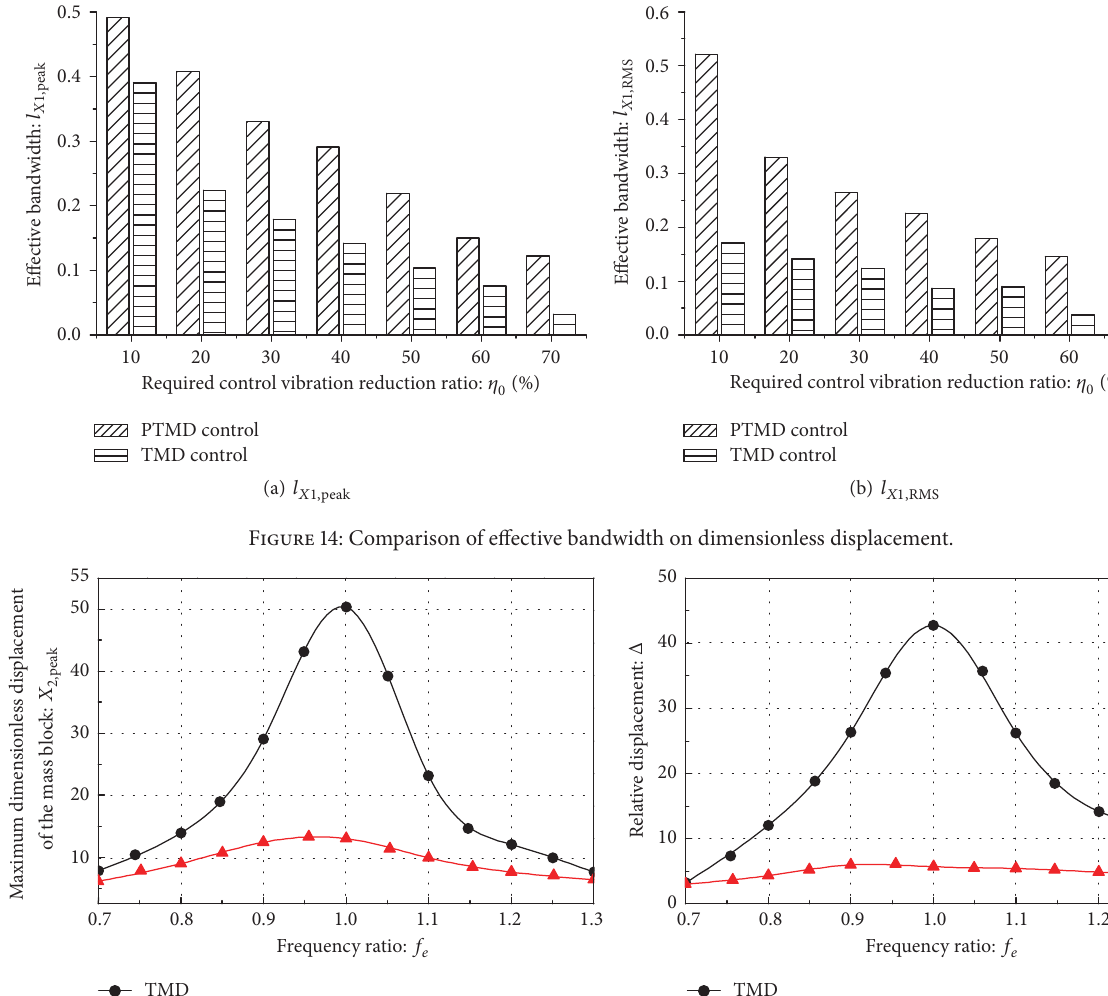
Figure 15: Response of the mass block and relative displacement (PTMD: 𝜉 2 = 3𝜉